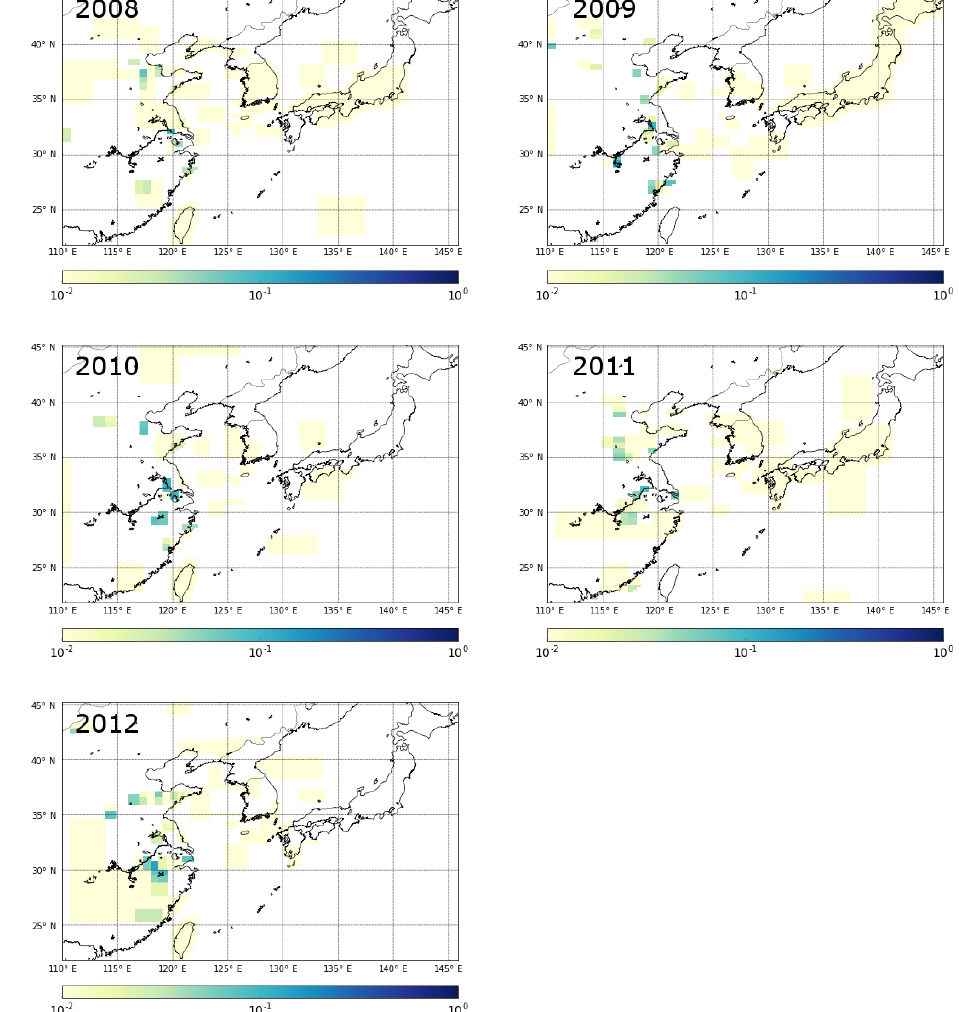
Figure 8. As for Fig. 6 but for